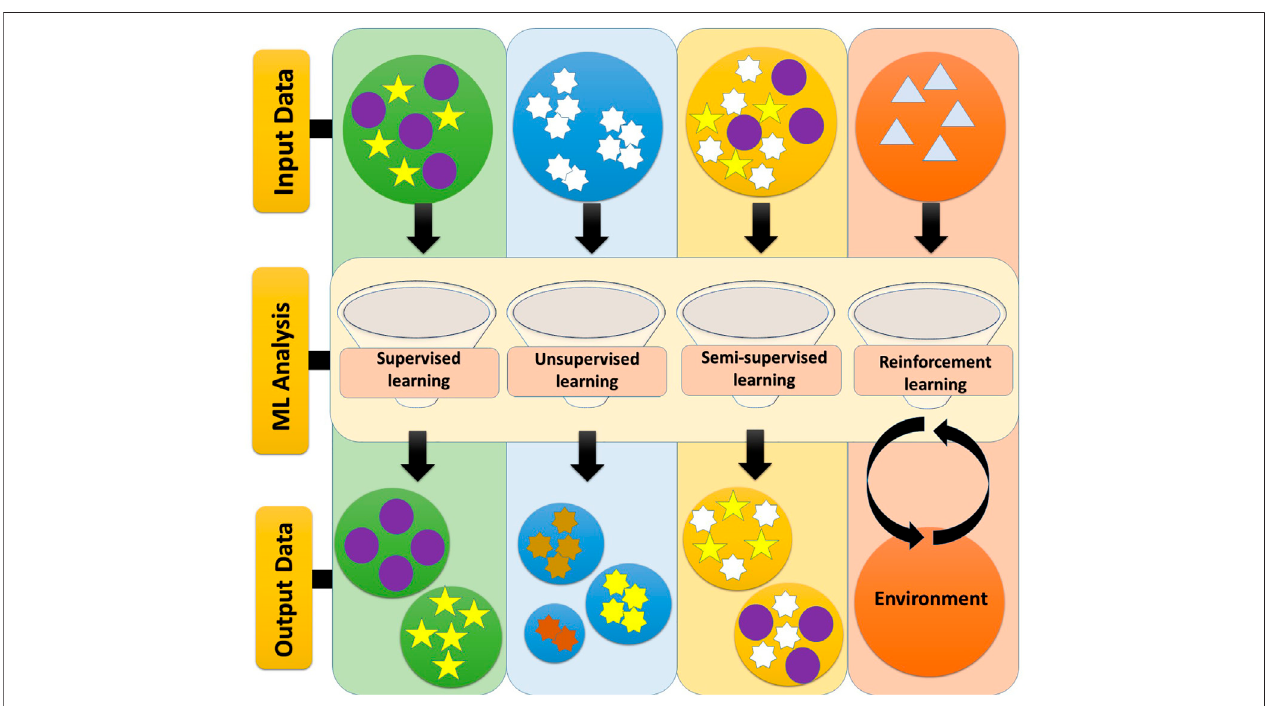
FIGURE 2 | ML approaches. The main approaches of machine learning include: 1) Supervised learning, 2) Unsupervised learning, 3) Semi-supervised Learning, and 4) Reinforcementlearning. Insupervisedlearning, theinputandoutputarespeci fi edand thedataislabeled.Inunsupervisedlearning,speci fi cdatadoes notalready exist and is not intended to be an input-output connection, but only to categorize them. Semi-supervised learning uses both labeled and unlabeled data simultaneously to improve learning accuracy. Reinforcement learning loop has a sequence of modes, actions, and rewards (Sedghi et al.,